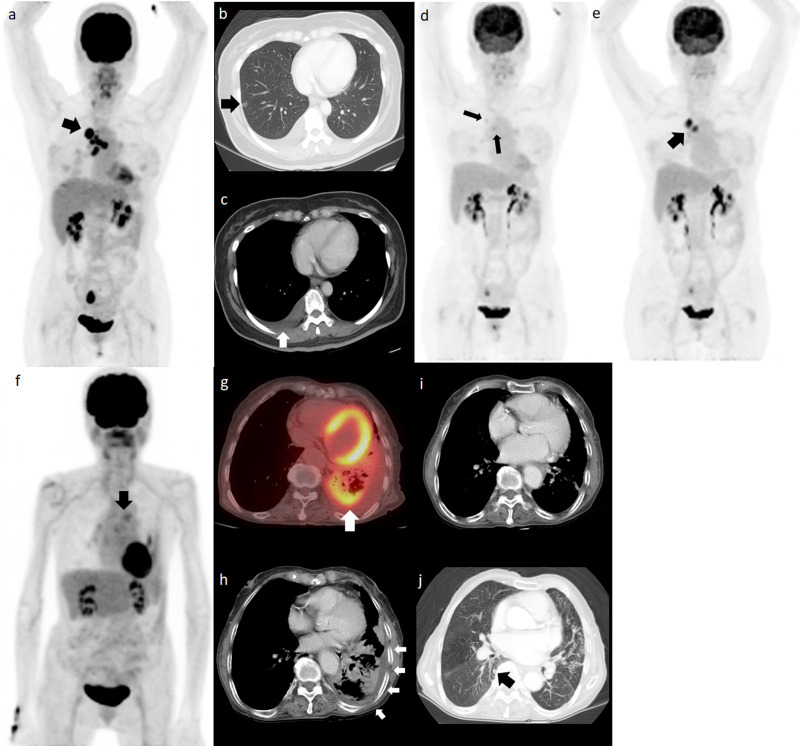
The survival prediction model outperforms the TNM staging system.Pretreatment 18F-FDG PET MIP image (a) for a 58-year-old woman with a primary tumor in the right upper lobe. Because of the presence of tiny nodule in different ipsilateral lobe and malignant pleural effusion (b and c, arrow), the clinical staging was cT4N3M1a. The EGFR mutation was L858R. The SUV entropy of the primary tumor was 5.32 (0.04 lower than the cut-off). A score of 1 was assigned for this patient. After 1 year of erlotinib treatment, the 18F-FDG PET MIP image (d) showed remarkable resolution of the primary tumor and metastatic lymph node 18F-FDG uptake (arrows). The patient experienced disease progression after 29.8 months of first line erlotinib treatment (e, arrow) and the treatment changed to osimertinib thereafter. The patient died of lung cancer with a PFS and OS of 29.8 and 54.3 months, respectively. The pretreatment 18F-FDG PET/CT and MIP images from an 83-year-old woman revealed mediastinal lymph node metastases (f, arrow) and an 18F-FDG avid tumor in the left lower lung (g, arrow). The patient also demonstrated malignant pleural effusion (h, arrows). Her clinical staging was cT3N3M1a and she had a deletion 19 EGFR mutation. The primary tumor SUV entropy was 5.44 (0.08 higher than the cut-off) and a score of 2 was given for this patient. She received erlotinib as a first line therapy. The CT acquired at 6 months after erlotinib treatment (i) showed resolution of the left pleural fluid; however, a new pulmonary nodule developed in the contralateral lung after 9.8 months of erlotinib treatment (j, arrow). The patient died of lung cancer progression with an OS of 18.1 months. MIP: Maximum intensity projection, PET: Positron emission tomography, EGFR: Epidermal growth factor receptor, PFS: Progression-free survival, OS: Overall survival.